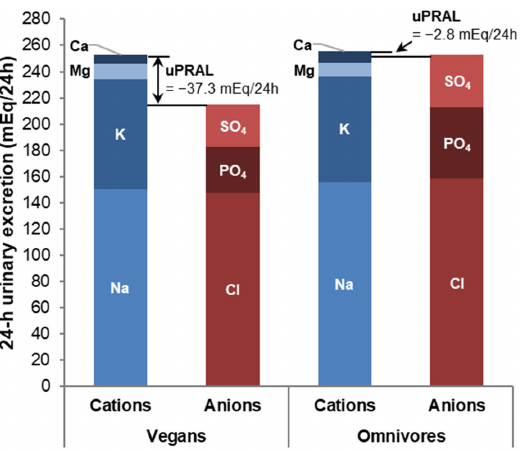
Figure 1. Urine ionogram of mean 24 h urinary excretions of cations and anions related to uPRAL (in mEq/24 h) among 34 vegans and 35 omnivores.